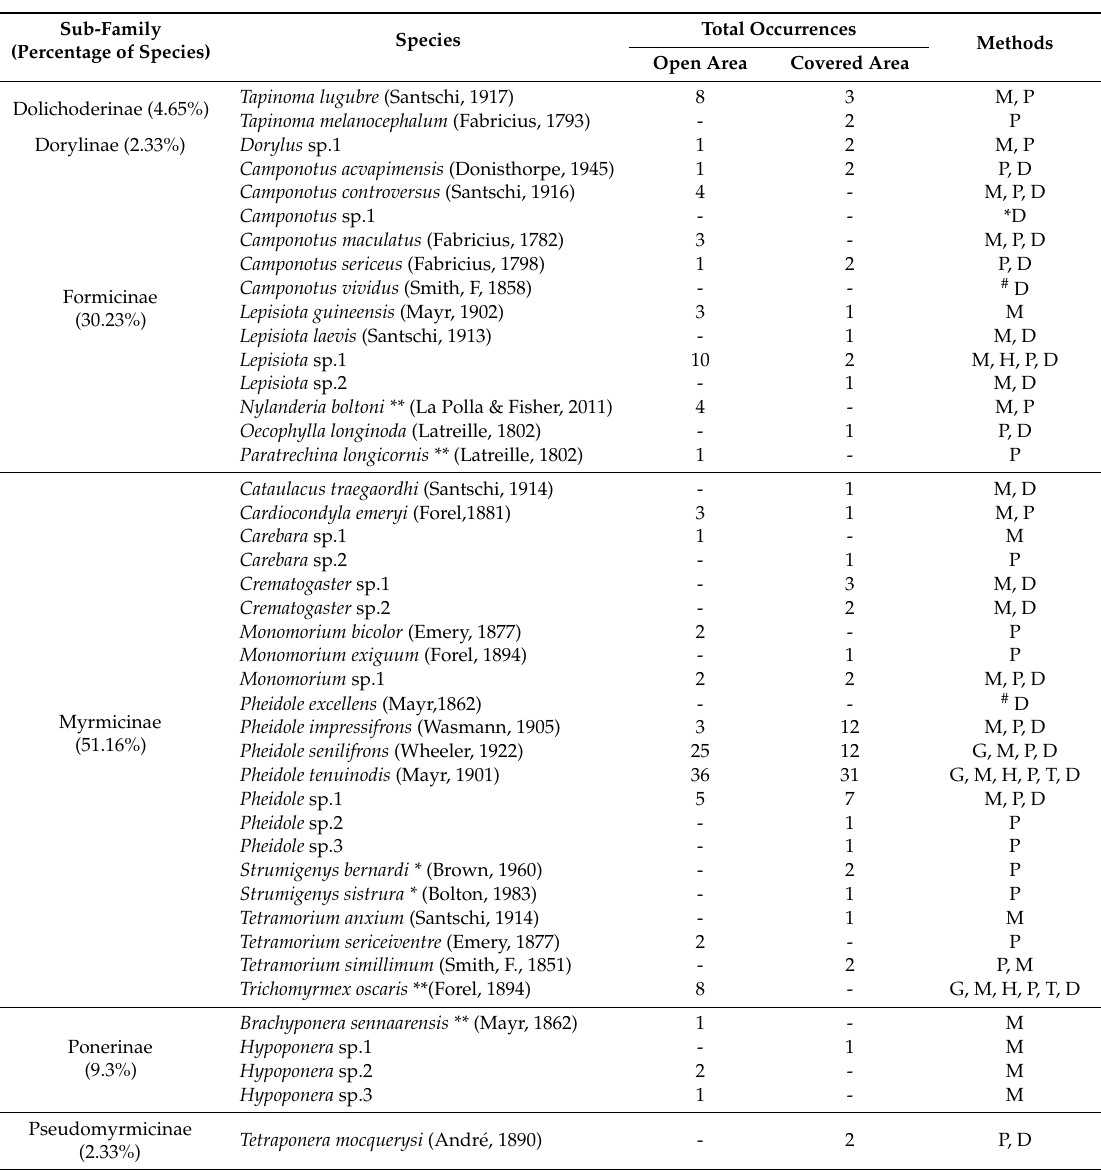
Table 2. The overall taxonomic composition of ants collected in the botanic garden with total number of species occurrences and sampling methods (D (direct sampling) , # D (Ants collected only through direct sampling) G (groundnut bait), H (honey bait), M (monolith), P (pitfall), T (tuna bait)). Potential bio-indicator species for *wooded habitats and **grass land